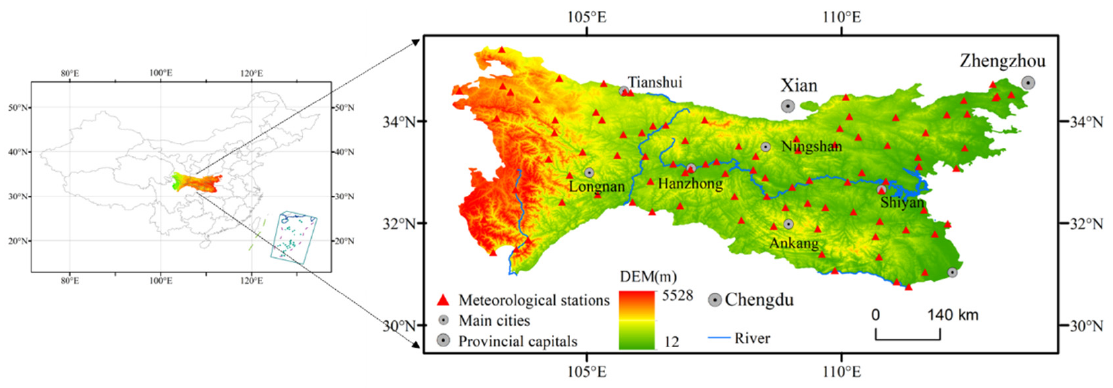
Figure 1. Distribution of meteorological stations in the Qinba Mountains.